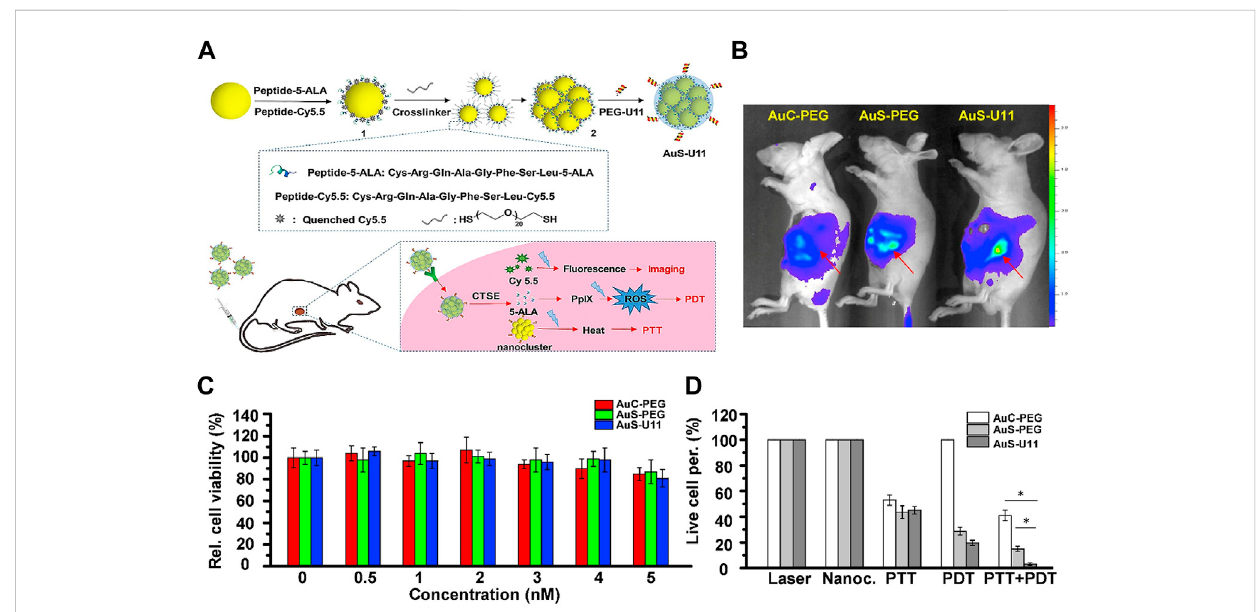
FIGURE 9 (A) .DesignandmechanismofCTSE-responsiveAuS-U11prodrugsystem; (B) . Invivo imagesofmicetreatedwithAuS-U11,AuS-PEGandAuC-PEG; (C) . Dark toxicities of AuS-U11, AuS-PEG and AuC-PEG against pancreatic ductal adenocarcinoma cells; (D) . Cell viabilities of AuS-U11, AuS-PEG and AuC-PEG upon PTT, PDT and combined PTT/PDT treatment under NIR irradiation. Adapted from ref. (Li H et al., 2017). Copyright 2017 Elsevier Ltd.